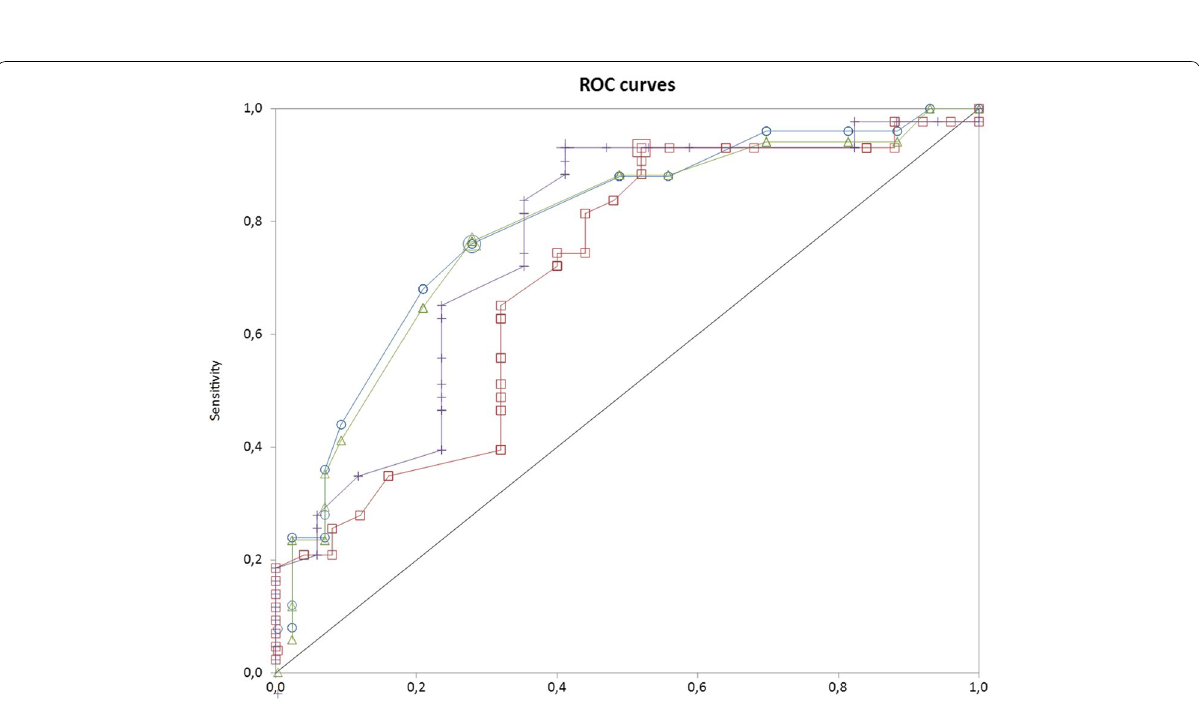
Fig. 3 ROC curves for predictive value of TI in successful weaning (SW) ( circle) and SE (Increment). In SW: LUSm AUC 0.8; TI AUC 0.71. In SE: LUSm AUC 0.78; TI AUC